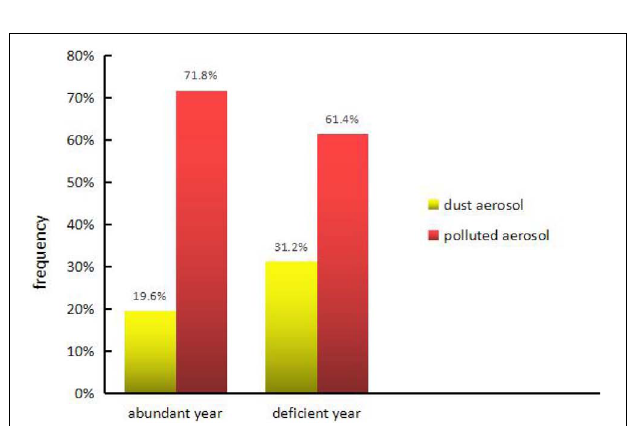
FIGURE 5 | The wind field in summer of ECMWF at 700 hPa ( above chart) and 850 hPa ( bellow chart) over the transition zone in abundant and deficient monsoon years ( Left : abundant years; Right : deficient years).